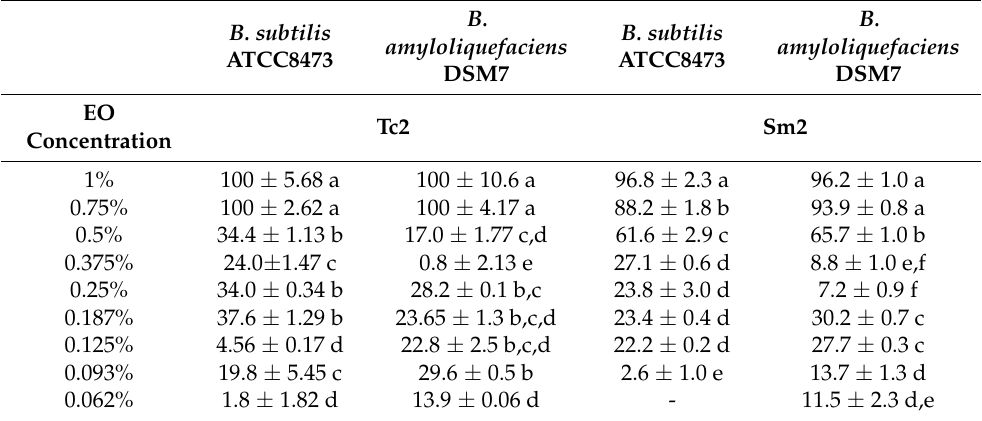
Table 6. Percent of inhibition (%) of bacterial growth ( B. amyloliquefaciens DSM7 and B. subtilis ATCC8473) after 24 h incubation at 37 ◦